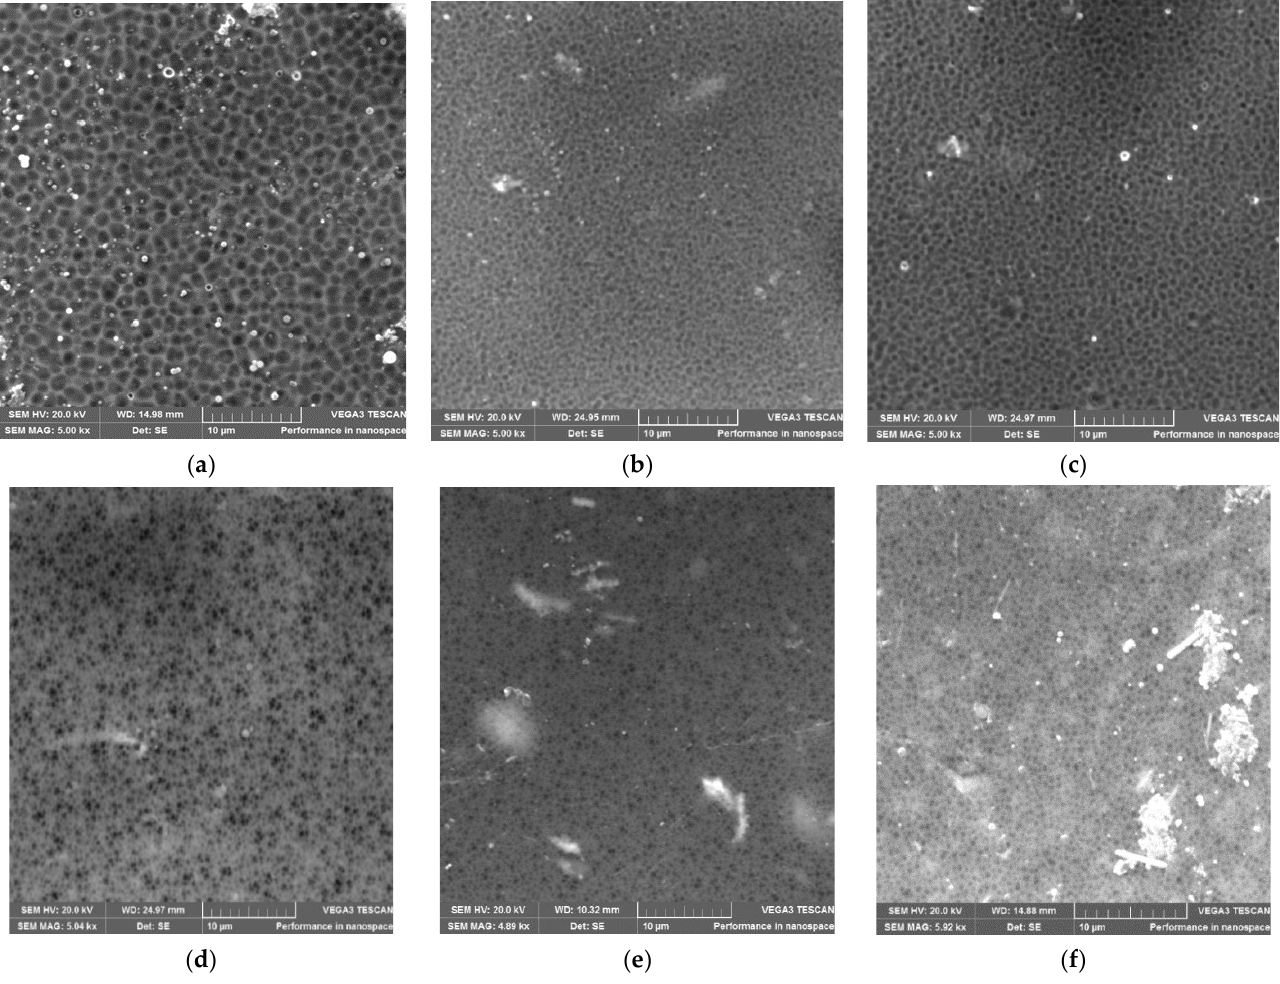
Figure 4. SEM surface micrographs of F60-ZSM-22/PES nanofiltration membrane materials prepared using F60-ZSM-22 as zeolite additives: ( a ) PES, ( b ) 0.1 wt.% F60-ZSM-22/PES, ( c ) 0.3 wt.% F60-ZSM-22/PES, ( d ) 0.5 wt.% F60-ZSM-22/PES, ( e ) 0.75 wt.% F60-ZSM-22/PES, and ( f ) 1.0 wt.% F60-ZSM-22/PES via phase inversion.